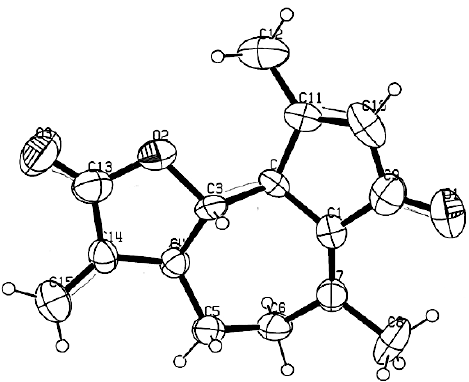
Figure 7. Non-volatile secondary metabolites isolated from the leaves of K. longipetiolata and identified by NMR spectroscopy. The numbers are referred to in Sections 1–3.